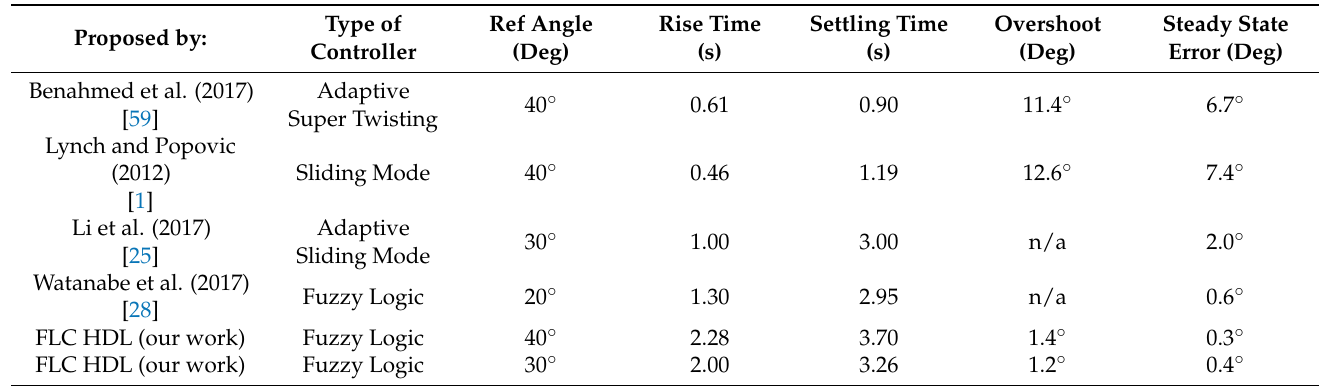
Table 8. Comparison of feedback controller performance from knee trajectory